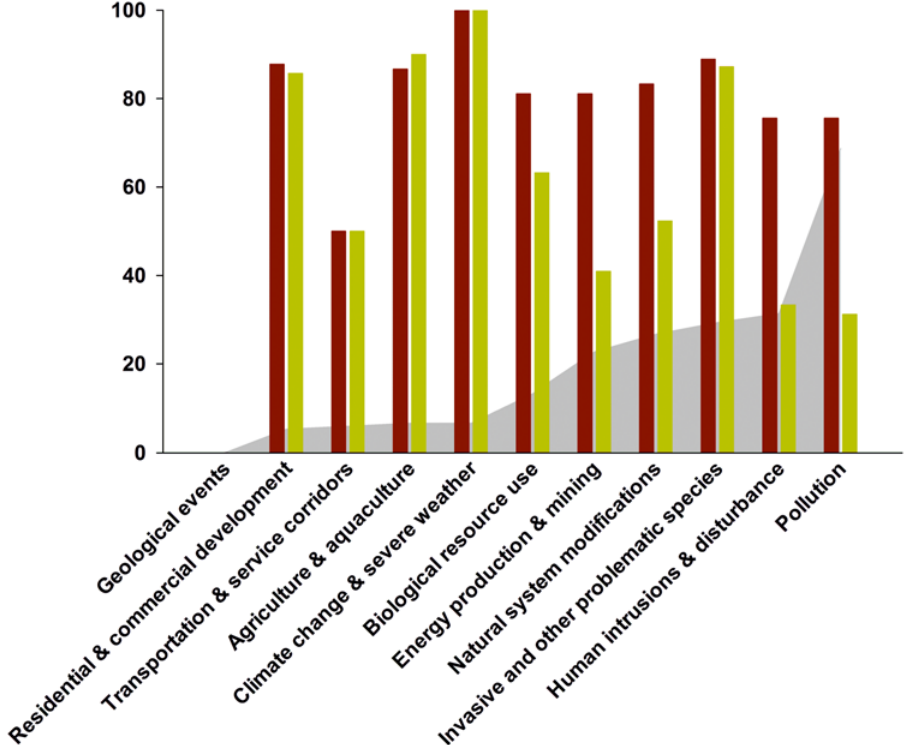
Fig 7. Major threats to freshwater shrimps. Incorporating the proportion of species impacted by each threat, the severity of the threat upon the species, and the overall threat impact score. The proportion of threatened and NT species impacted by each threat category is shown in grey; the proportion of species- threat interactions causing rapid/very rapid declines is shown in red, whilst the average threat impact score (normalised) to 100 is shown in green. Calculations for the latter two indicators are based on threatened and NT species